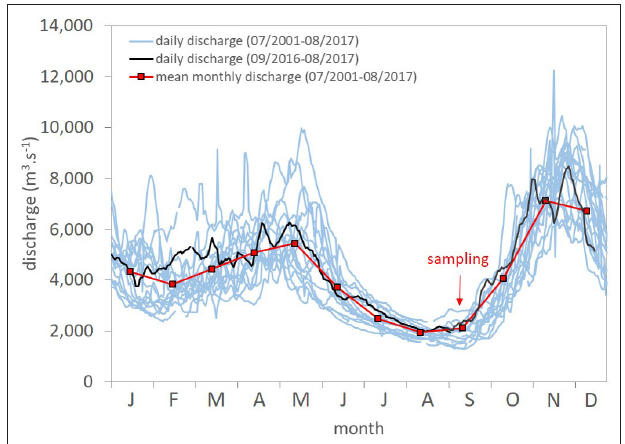
FIGURE 3 | Daily discharge (07/2001 to 08/2017) and mean monthly discharge of the Ogooué River at the Lambaréné station (Bogning et al., 2018). See photo of the Ogooué River at Lambaréné City ( Figure 2F